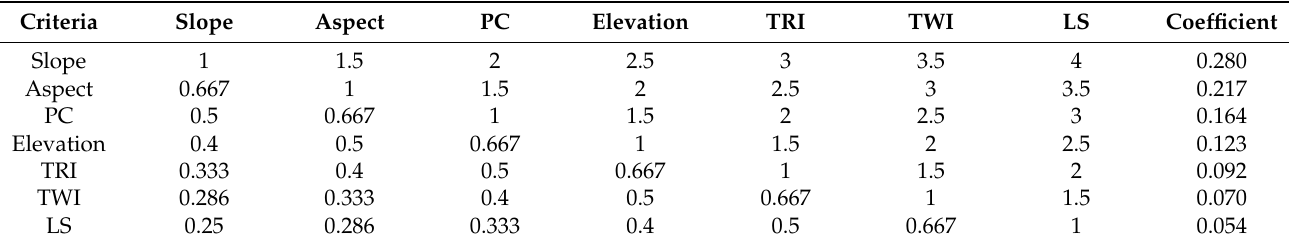
Table 4. Matrix of geomorphological subindicators.